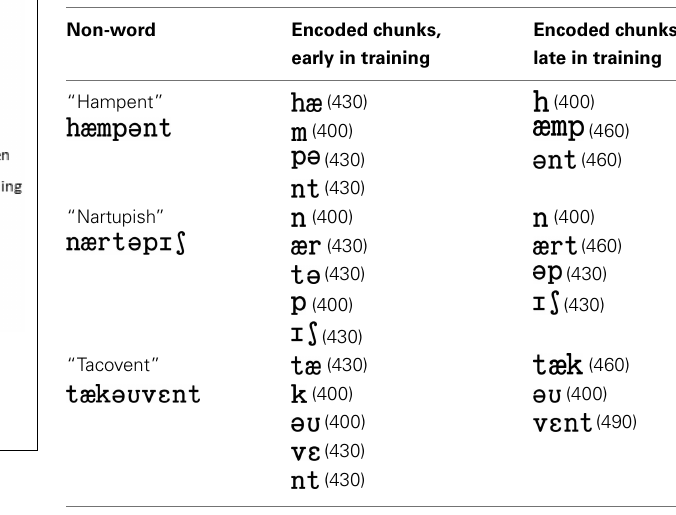
Table 1 | Encoded chunks for three example